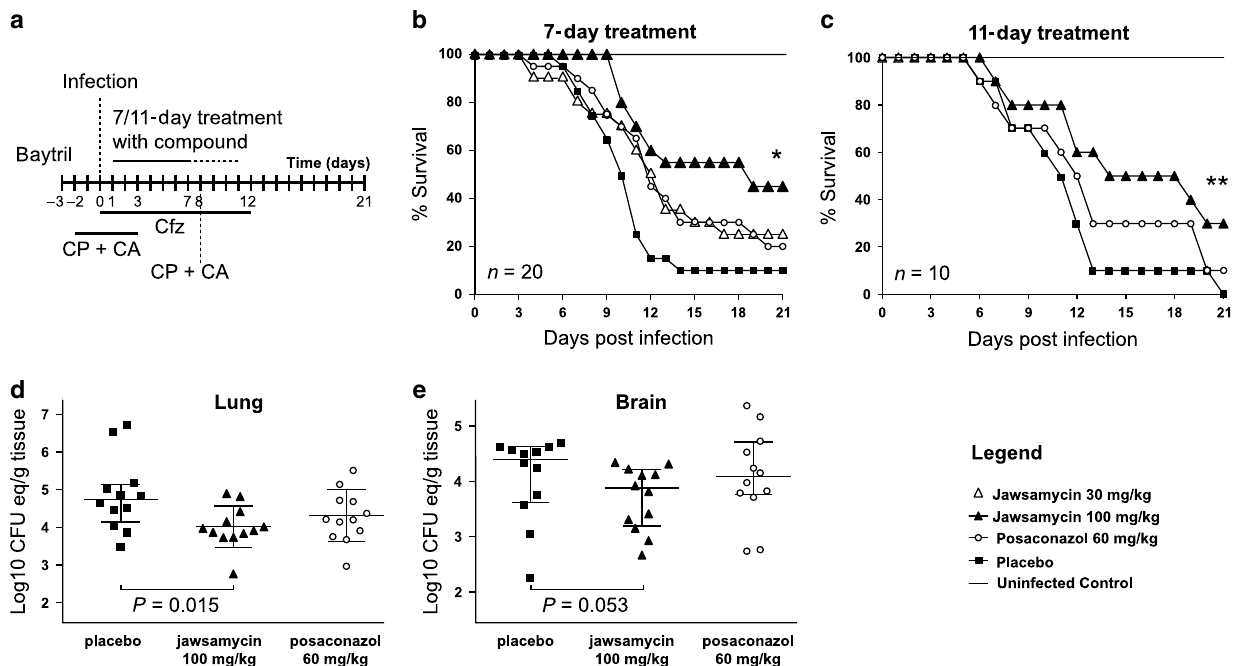
Fig. 5 Testing of jawsamycin in a murine pulmonary mucormycosis model. a Outline of experiment. On day 0, mice were infected with 2.5 × 10 5 spores of R. delemar by intratracheal instillation. CP cyclophosphamide, CA cortisone acetate, Cfz ceftazidime. Mice were treated for either 7 days ( b ) or 11 days ( c ) with the indicated compound treatments. b , c Kaplan – Meier plots depicting survival of mice under the different treatment regimens over 21 days. b n = 20 mice/group from two independent experiments with similar results (con fi rmed average fungal spores delivered to lungs of 2.4 × 10 3 ). c n = 10 mice/group from one experiment (con fi rmed fungal spores delivered to the lungs of 3.7 × 10 3 ). *P = 0.0014, and ** P = 0.045 vs. placebo in b , c , respectively. d , e Tissue fungal burden of lungs and brain harvested from 12 mice/group and processed on day 7 post infection. Tissue fungal burden was determined by real-time qPCR and expressed as Log10 CFU (colony forming units) equivalent/gram of tissue. P values < 0.05 were considered signi fi cant (details on data analysis and statistical signi fi cance are described in the Methods